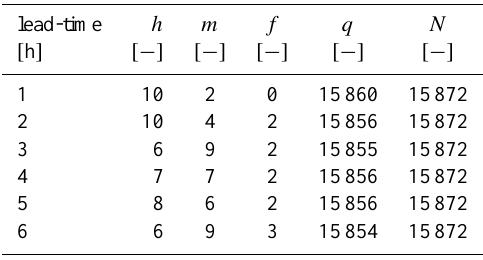
Table 3. Performance of the FFWRS based on deterministic fore- casts, expressed in the elements of a contingency table.